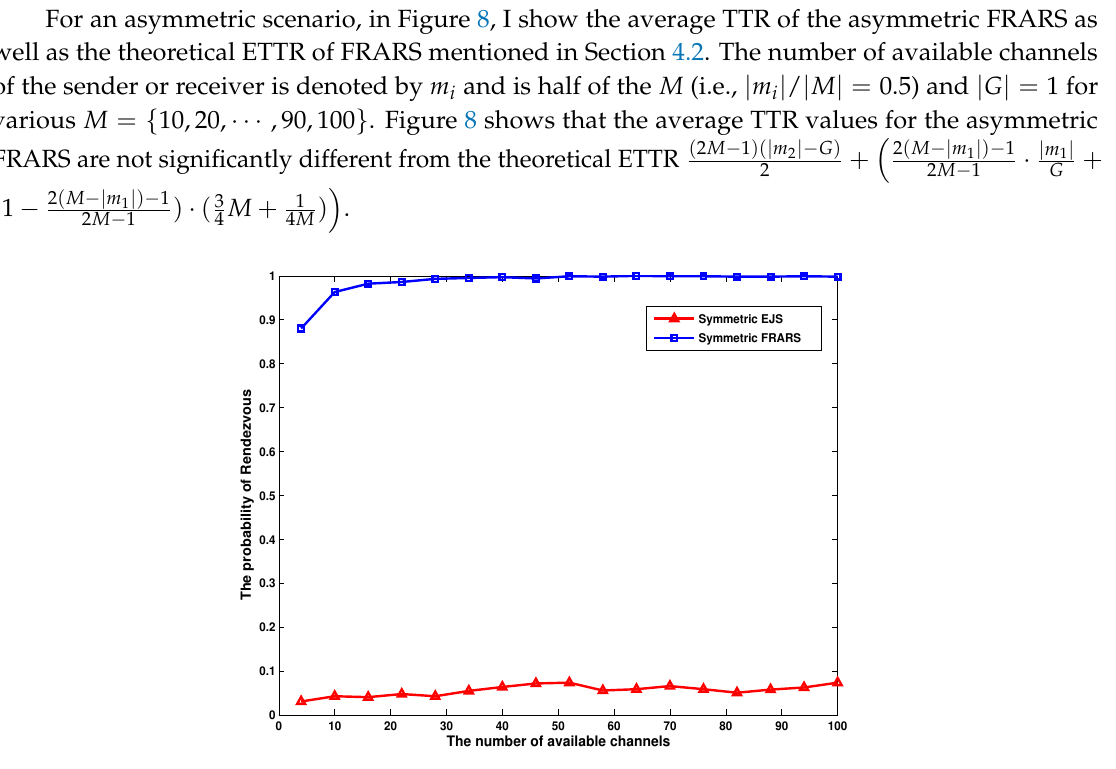
Figure 7. The probability of rendezvous for the symmetric EJS and FRARS schemes under CDJA attacks with M = [ 4, · · · ,100 ] .